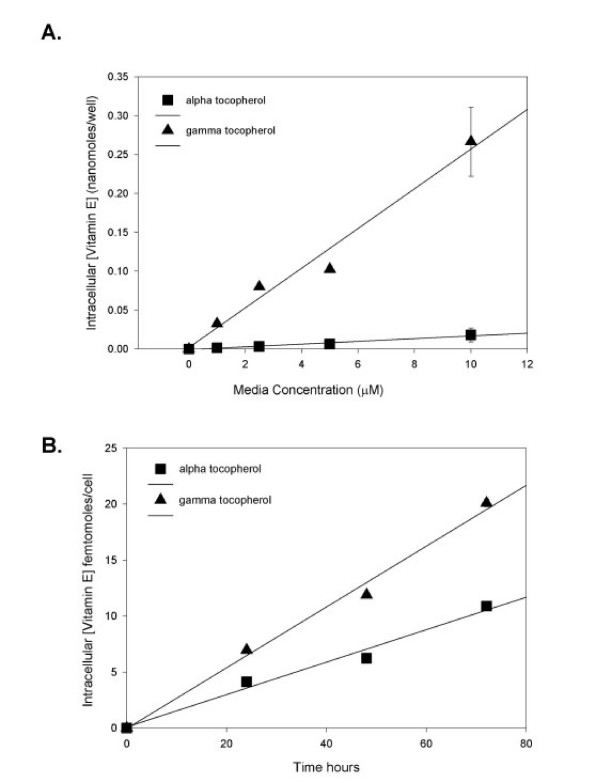
Cellular up take of RRR-α- and RRR-γ-tocopherol is time and concentration dependent, with RRR-γ-tocopherol accumulating to a higher intracellular concentration. A) SW480 cells were treated with varying concentrations of RRR-α- and RRR-γ-tocopherol for 24 hours. B) SW480 cells were treated with 100 μM RRR-α- or RRR-γ-tocopherol, collected, counted and subjected to HPLC analysis after 24, 48 and 72 hour treatments. Values are average of three independent experiments and error bars represent standard deviation. Time-dependent HPLC values were normalized to cell counts due to cell death at longer time intervals.